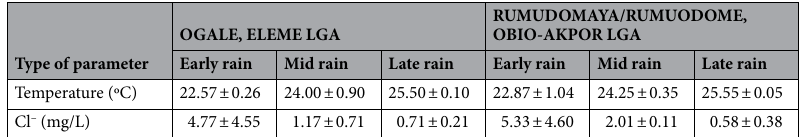
Table 13. shows values of temperature and chloride ion in ambient rain water samples within the